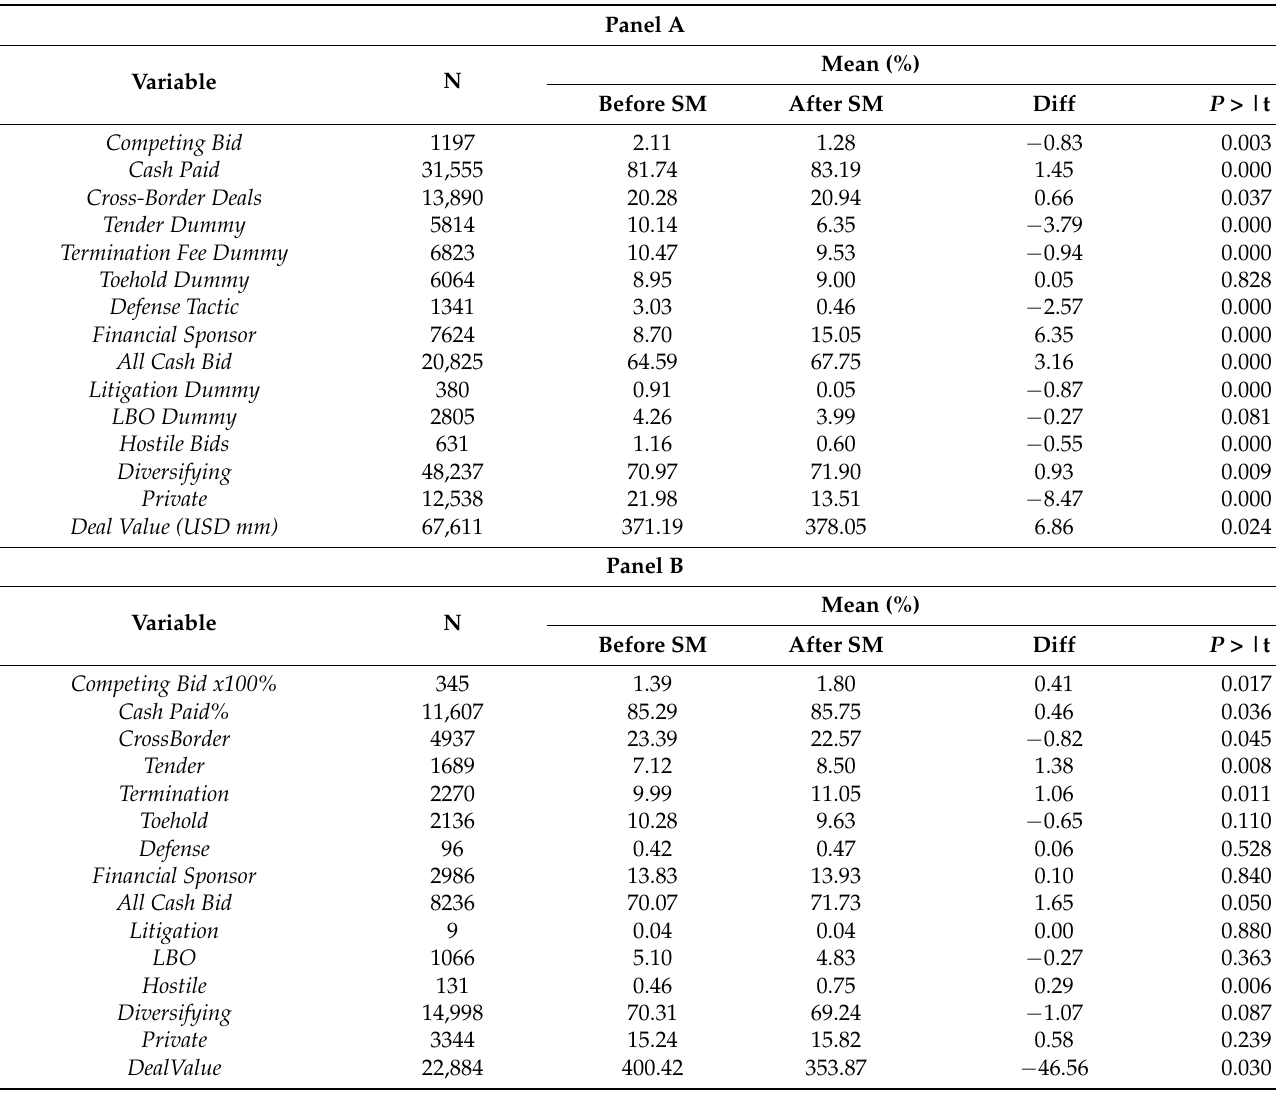
Table 3. Summary statistics on the sample of individual deals and their characteristics before and after the mean year in which social media became popular globally. ( Panel A ) includes all deals throughout the sample period, 1990 to 2016. ( Panel B ) takes only those deals that were announced 3 years before and after social media became popular in the country where the deal took place. The final column shows the p-value of a t-test for whether Diff is significantly different from 0. ( Panel C ) Difference-in-difference analysis of early and late adopters of social media. Early adopters are countries where social media became popular in 2007 or earlier (N = 25). Late adopters are countries where social media became popular in any year after 2007 (N = 21). Before SM and After SM refer to the mean values of the variables before and after 2007. ( Panel D ) Difference-in-difference analysis of early and late adopters of social media. Early adopters are countries where social media became popular in 2007 or earlier (N = 25). Late adopters are countries where social media became popular in 2010 or 2013 (N = 7). Before SM and After SM refer to the mean values of the variables before and after